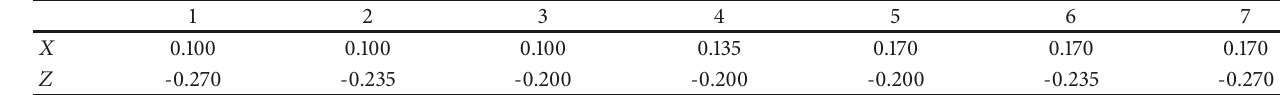
Table 1: Key points in the foot trajectory.